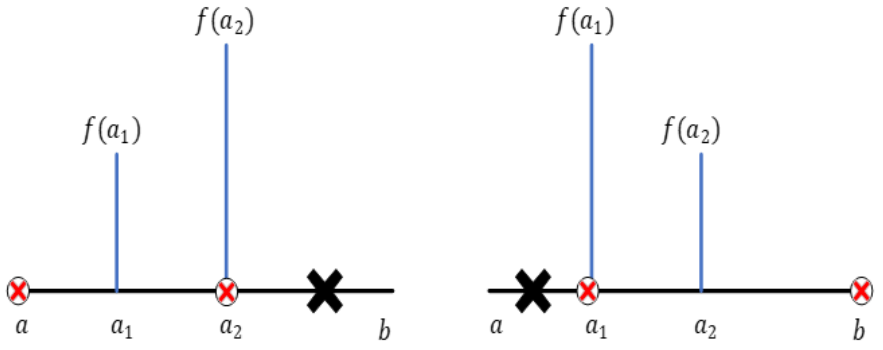
Figure 8. Schematic diagram of fast search method interval elimination.